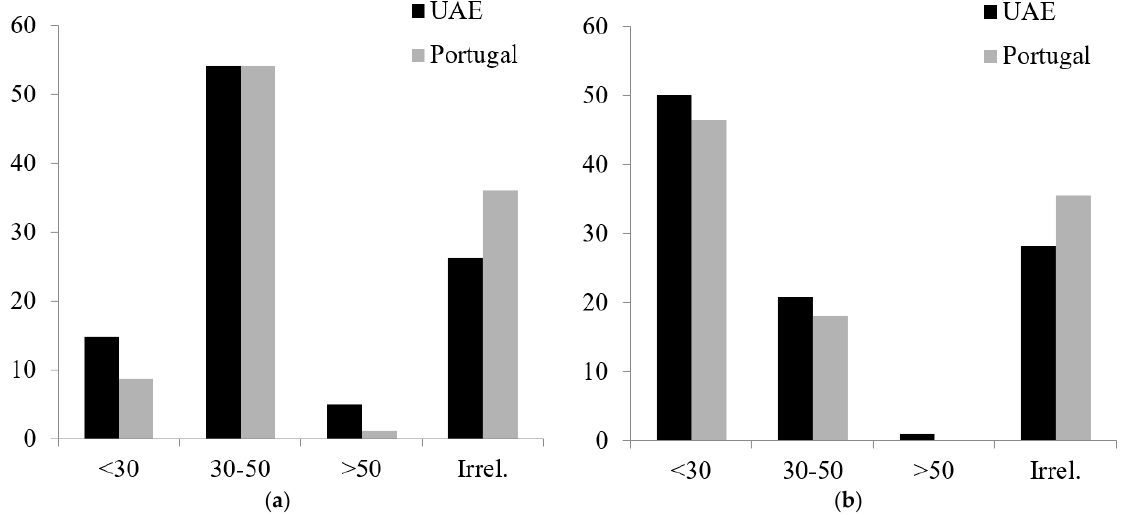
Figure 1. Ages more likely to get breast cancer and to undergo breast examination (percentages for both groups). ( a ) Age of BC onset. ( b ) Age for BC screening. Note: “Irrel.” Refers to “age does not matter” option. matter”